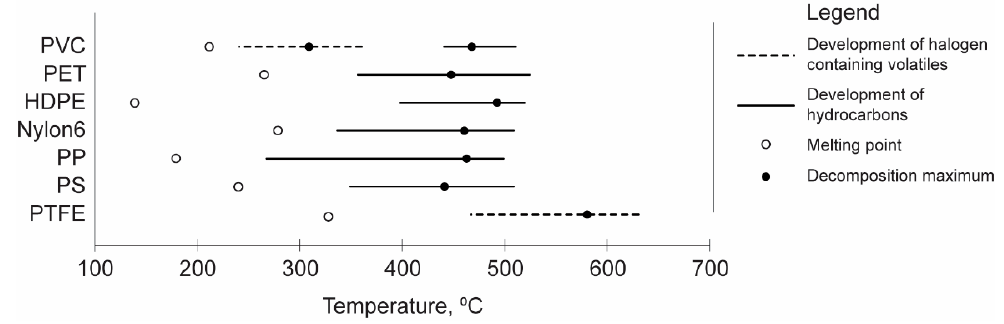
Figure 1. Decomposition temperature of various polymers.